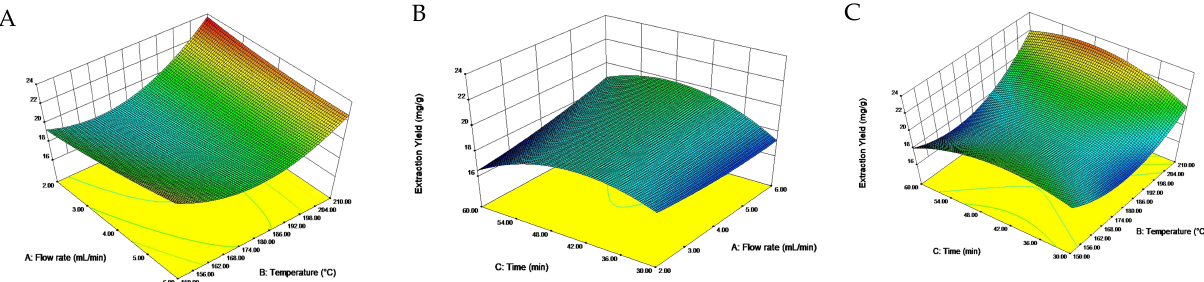
Figure 1. Interaction effects of factors on total saponins extraction yield in quinoa husks. ( A ) the interaction of flow rate and temperature; ( B ) the interaction of time and flow rate; ( C ) the interaction of time and temperature.